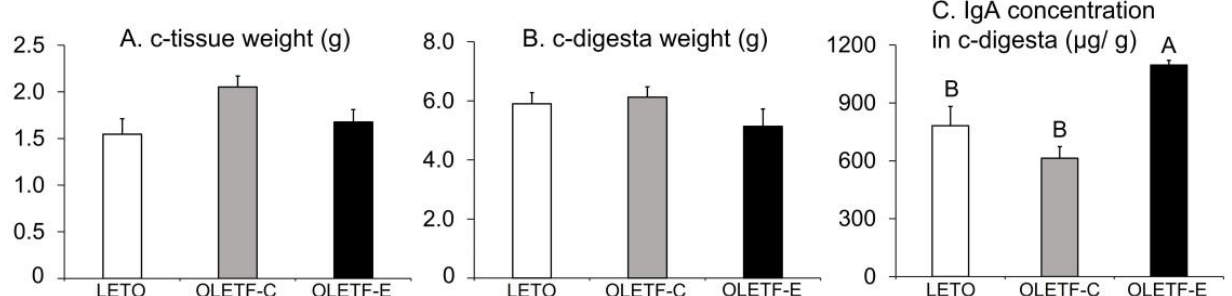
Figure 4. Cecal tissue (c-tissue) weight ( A ), cecal digesta (c-digesta) weight ( B ), and IgA concentra- tions in c-digesta ( C ) 16 weeks after the start of this study. n = 5 per group. The bars represent mean values, and the error bars represent SE. Significant differences were determined using the one-way ANOVA, followed by multiple comparisons using Tukey’s post -hoc test. The letters represent sig- nificant differences between groups ( p < 0.05, Tukey’s post -hoc test). There were no significant dif- ferences in the c-tissue and c-digesta weights among the three groups ( p = 0.06 and 0.3, one-way ANOVA).